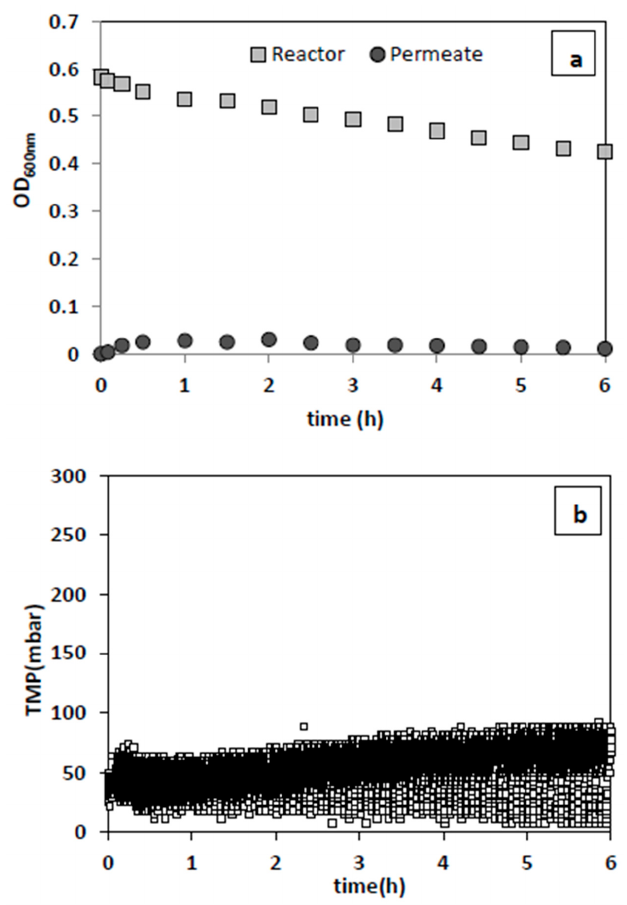
Figure 6. Changes in the ( a ) turbidity of the reactor (R) and permeate line (P) and ( b ) TMP during filtration of a mixed culture of bacteria and yeast in PBS medium. (The upper curve represents the changes in TMP during forward filtration, and dispersed points under that curve are the latent effects of the BW pressure readings). Fermentation 2018 , 4 , x FOR PEER REVIEW